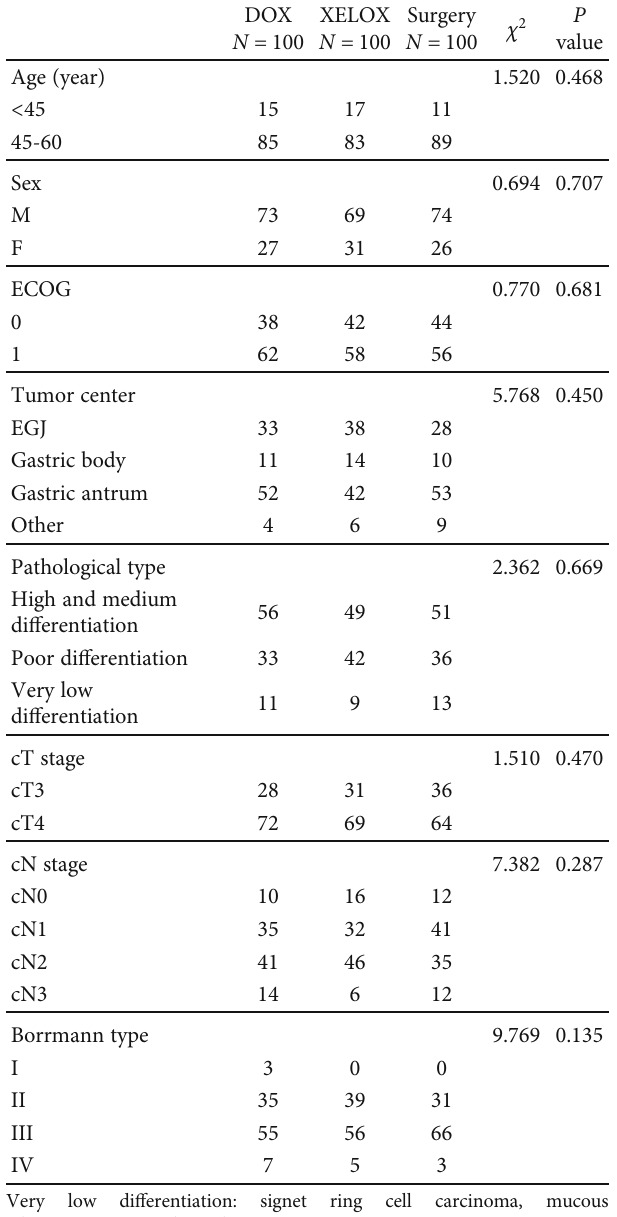
Table 1: General clinical characteristics of patients in the three